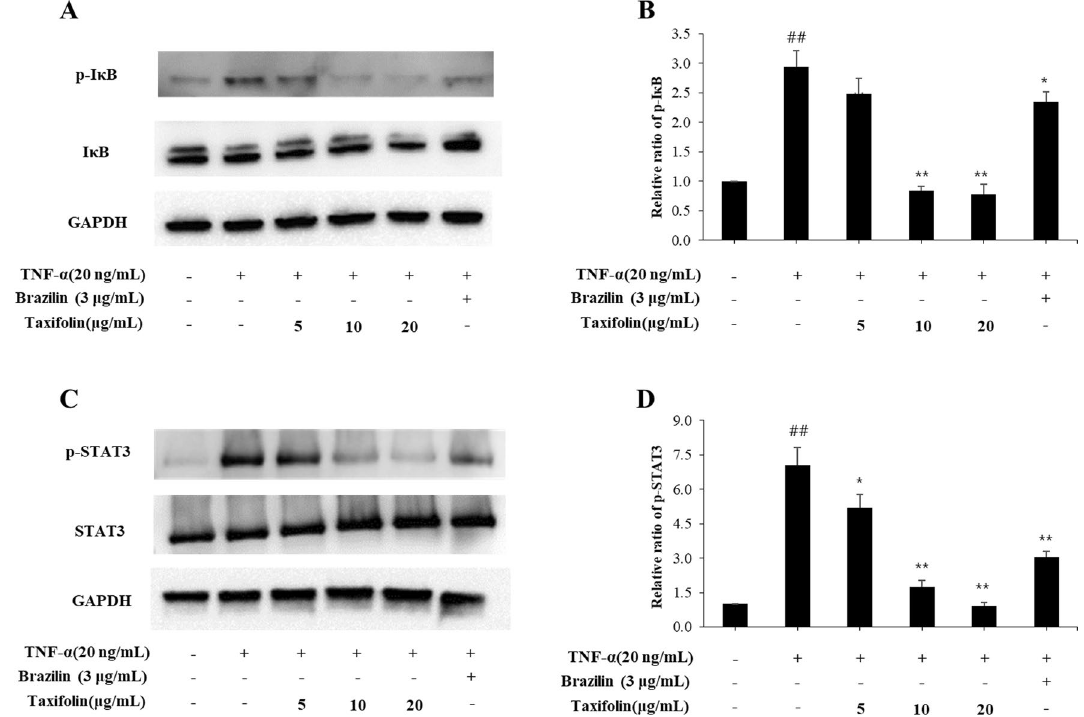
Fig. 2 Taxifolin regulates IκB and STAT3 protein activation in TNF-α signal pathway. A IκB phosphorylation in the presence of TNF-α was inhibited by taxifolin. Although similar expression levels of IκB protein were observed under various conditions, IκB phosphorylation was significantly inhibited by taxifolin, strongly suggesting an anti-inflammatory activity of taxifolin through regulation of IκB phosphorylation. B p-IκB/IκB level was quantified with ImageJ program. C Taxifolin inhibited STAT3 phosphorylation as a concentration-dependent manner. GAPDH was used as a loading control. D Quantification of p-STAT3/STAT3 level with ImageJ program. ##, p < 0.01 versus untreated control; *, p < 0.05 and **, p < 0.01 versus TNF-α treated